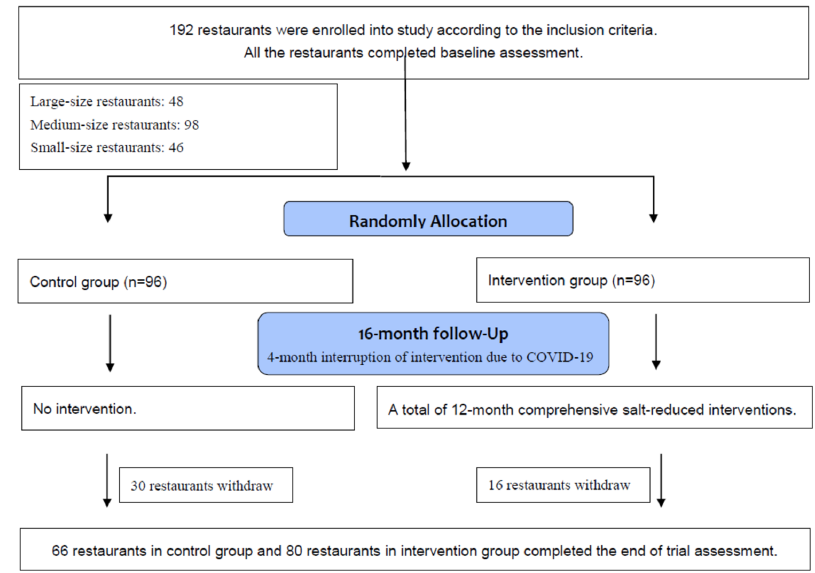
Figure 1. Trial profile of restaurant-based intervention to reduce salt in China.